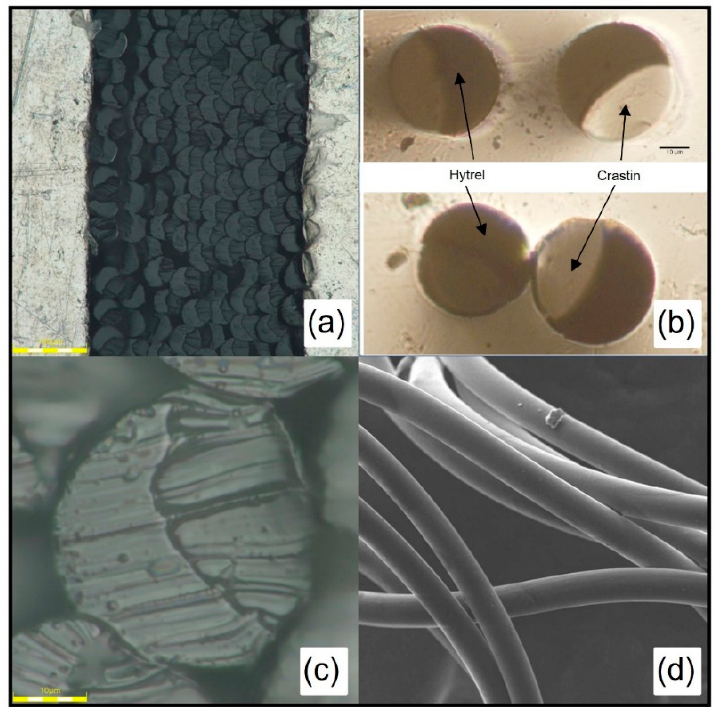
Figure 2. Side-by-side fiber cross sections and surface morphology. ( a ) displays overall filament morphology, ( b ) shows zoomed in photo showing two distinct phases, ( c ) displays a zoome in photo of single filament, and ( d ) SEM of the fiber